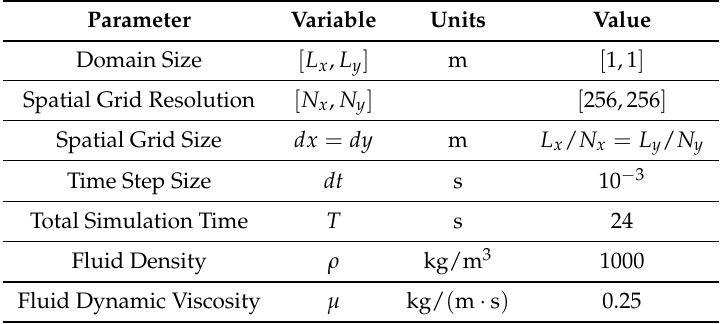
Table 4. Numerical parameters for the whirlwind simulation for Re =